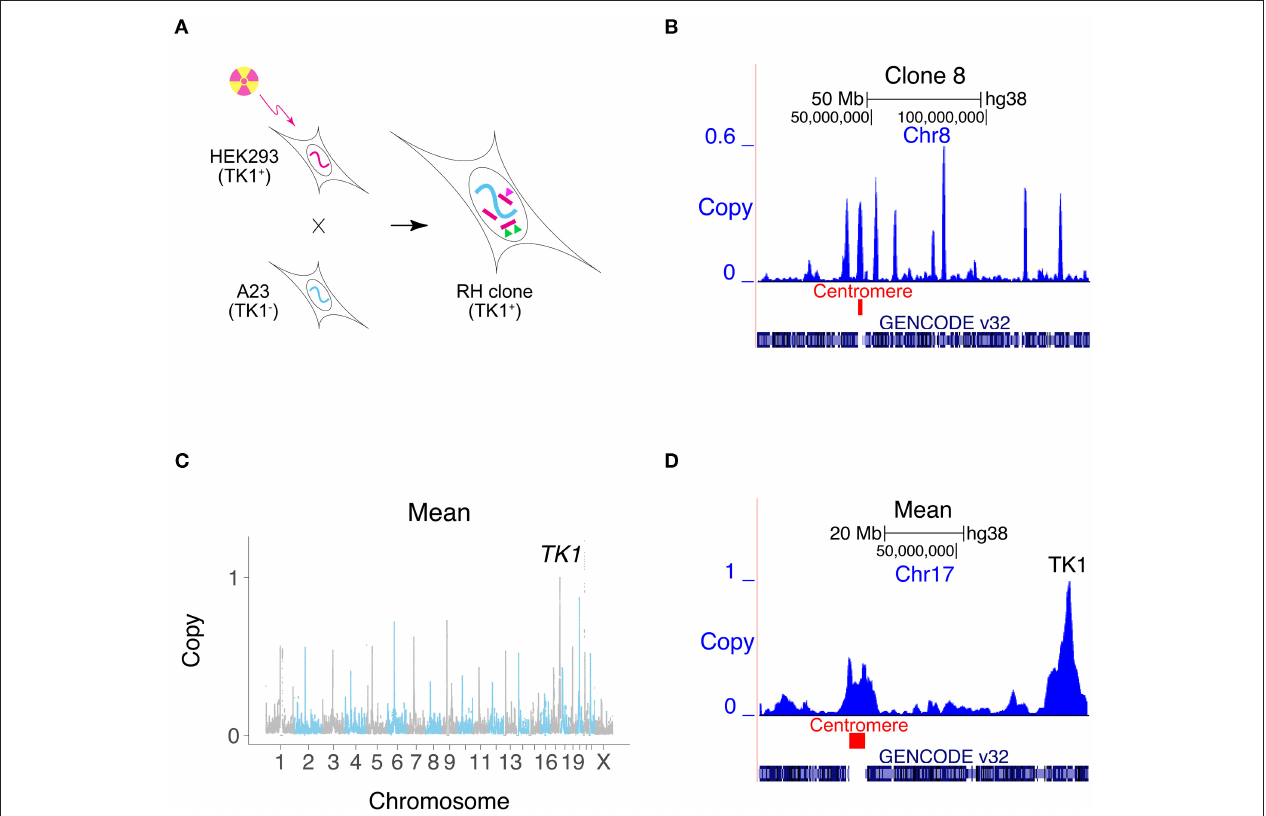
FIGURE 1 | Creating RH interaction networks. (A) RH clones are made by lethally irradiating human cells (HEK293). The human cells are fused to living hamster cells (A23) to rescue the DNA fragments, and RH clones selected using TK1 . Conventional RH mapping exploits the fact that nearby makers tend to be found on the same DNA fragment and thus co-inherited (green triangles). RH interaction networks seek co-inheritance of distant markers (green and pink triangles). (B) Human DNA copy number, clone 8, Chromosome 8. One of the human fragments encompasses the centromere. (C) Mean retention across 15 clones, showing increased retention at centromeres and retention of 1 at TK1 . (D) Mean retention across clones, Chromosome